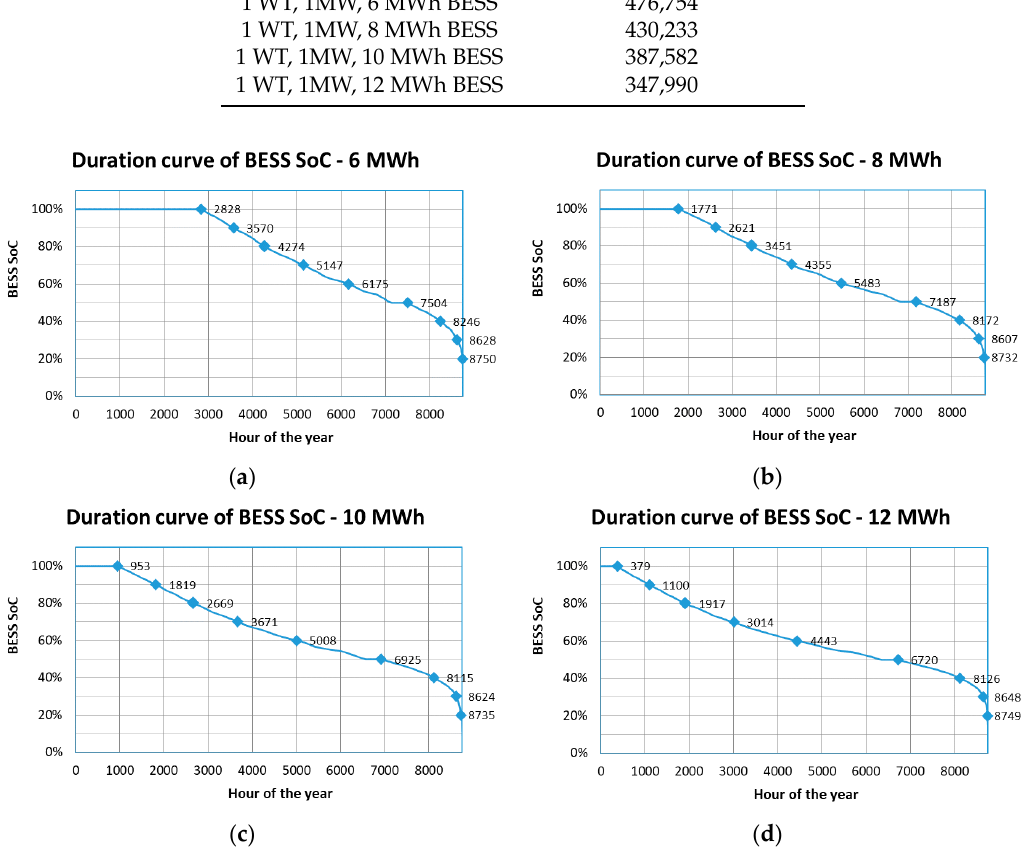
Figure 6. Duration curve for state of charge (SoC) for systems with 1 WT and different BESS capacity: ( a ) 6 MWh; ( b ) 8 MWh; ( c ) 10 MWh; ( d ) 12 MWh.